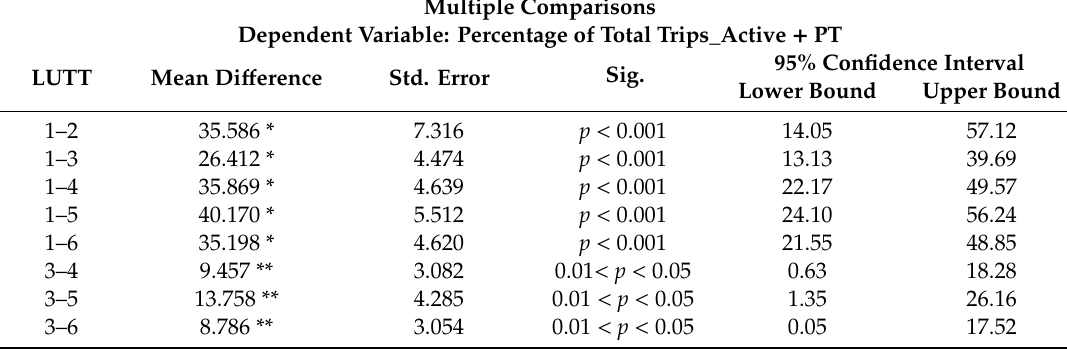
Table 7. Mean and Standard Errors